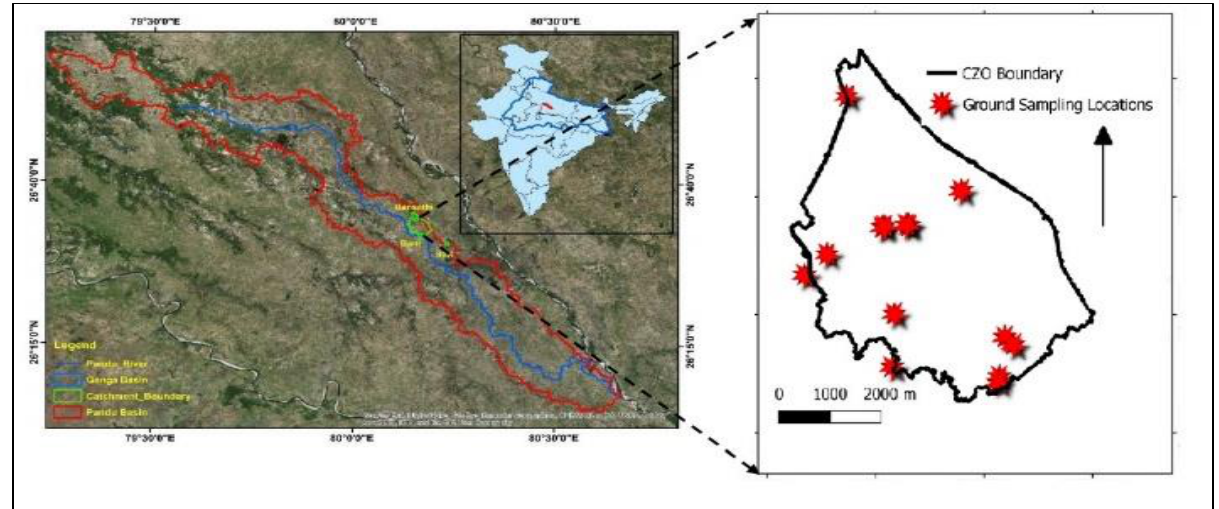
Figure 1. The study area and the locations of stations in soil moisture sensor network (Gupta et al., 2018)